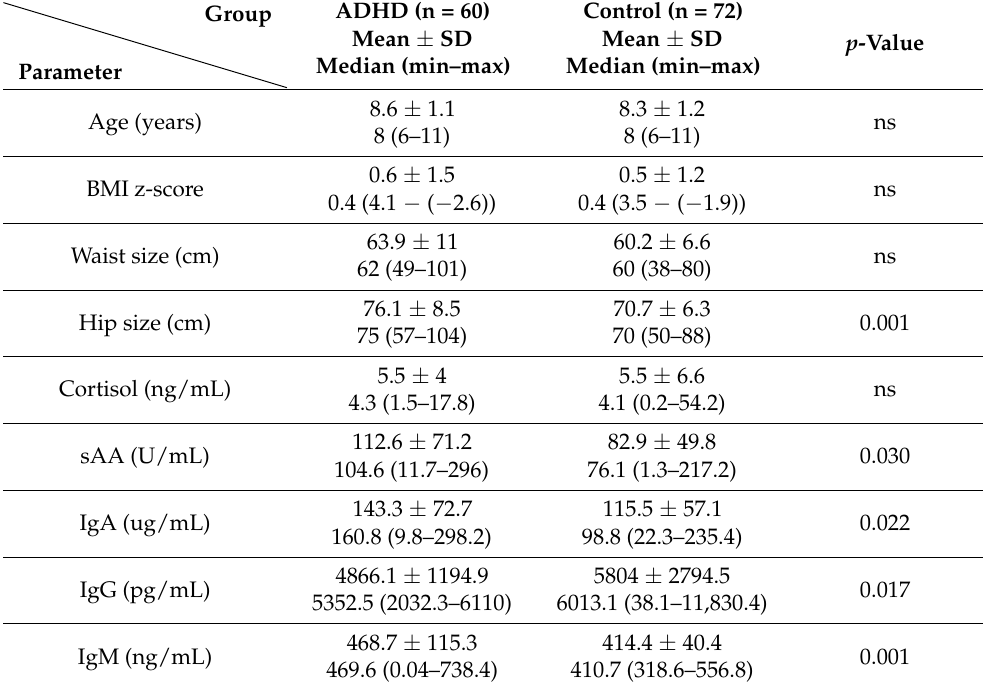
Table 2. Anthropometric data and salivary concentrations of cortisol, alpha-amylase (sAA), and IgA, IgG, and IgM in the ADHD and control